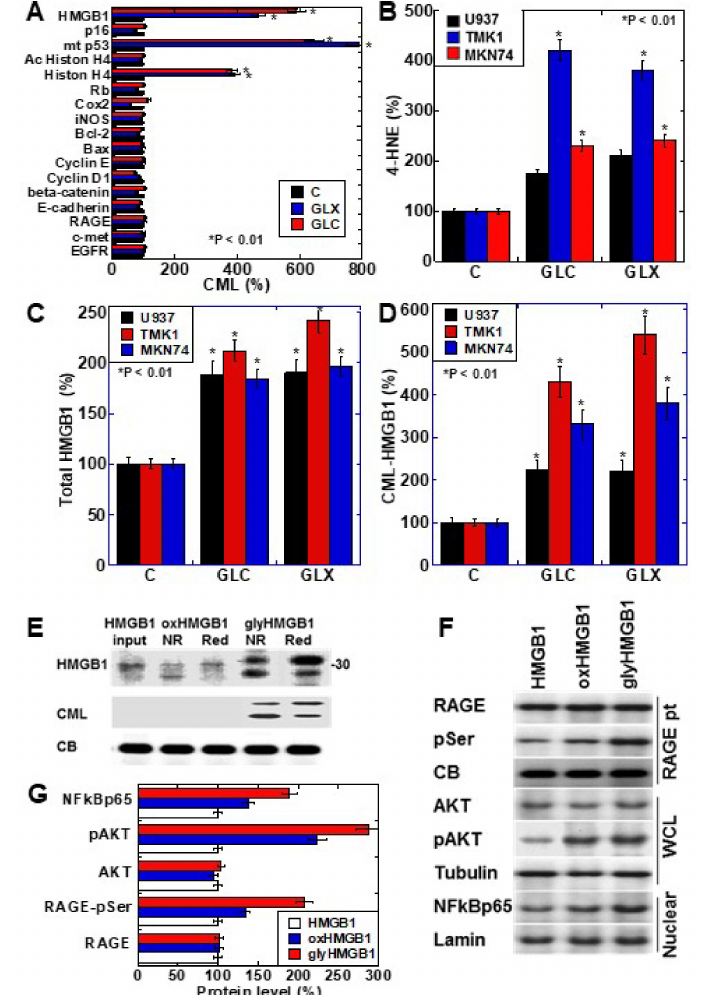
Figure 1. CML-HMGB1 formation in gastric cancer cells. ( A ) CML formation in various cancer-associated proteins was analyzed by antibody array using immunoprecipitant by anti-CML antibody of TMK-1 cell lysate, which was treated with GLX or GLC. The Scheme 100. ( B ) Oxidative stress levels in cells treated with GLX or GLC as measured by ELISA. ( C ) Total HMGB1 levels in cells treated with GLX or GLC as measured by ELISA. ( D ) CML-HMGB1 levels in cells treated with GLX or GLC measured by immunoprecipitation; immunoprecipitant by anti-CML antibody was detected by anti-HMGB1 antibody. ( E ) H 2 O 2 -treated HMGB1 (oxidized HMGB1) and GLX-treated HMGB1 (glycated HMGB1) were examined by Western blot analysis under non-reduced (NR) or reduced (Red) conditions. The membrane was re- probed with an anti-CML antibody (CML). ( F ) Alterations in HMGB1-associated intracellular signals in TMK-1 cells treated with naïve HMGB1 (10 µ g/mL), oxidized HMGB1 (10 µ g/mL), or glycated HMGB1 (10 µ g/mL). ( G ) Semi-quantification of protein levels with standardization by CB, tubulin, or lamin. Phosphorylated RAGE (pSer) was examined by immunoprecipitation; RAGE precipitant was detected using an anti-pSer antibody. CB, tubulin, and lamin were used as the loading controls. Error bar and standard deviation calculated by ordinary analysis of variance from three independent experiments. CML, N ε -( Carboxymethyl ) lysine ; HMGB1, high-mobility group box-1; C, untreated control; GLX, glyoxal; GLC, glucose; RBP, retinol-binding protein; 4-HNE, 4-hydroxynonenal; NR, non-reduced condition; Red, reduced condition; CB, Coomassie blue; RAGE, receptor for advanced glycation end products; pSer, phosphorylated serine; pAKT, phosphorylated AKT; .NF- κ B, nuclear factor- κ B; RAGE pt, anti-RAGE antibody precipitant; WCL, whole cell lysate; Nuclear, nuclear fraction. * P <